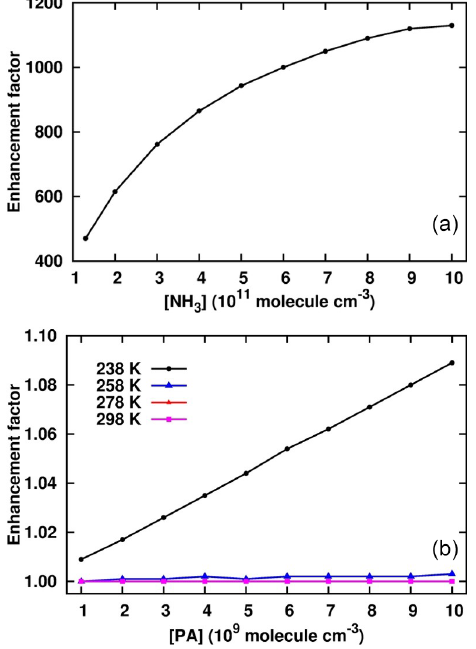
Figure 5. Enhancement of PA in the cluster formation rate in the sulfuric-acid–pyruvic-acid–ammonia clusters at [ SA ]= 10 6 molec . cm − 3